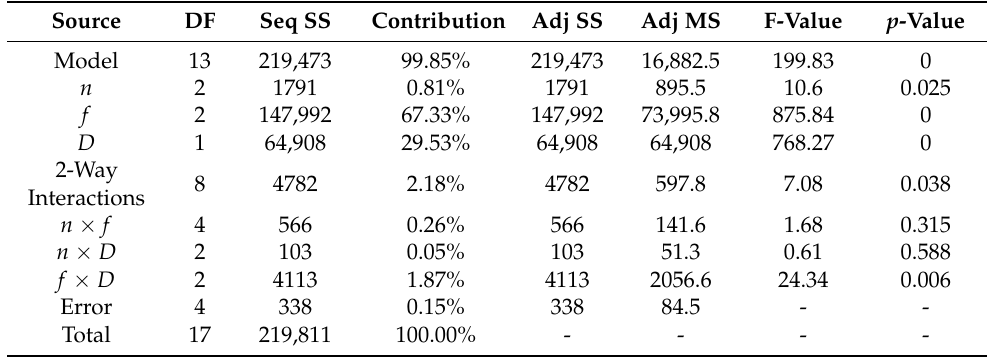
Figure 2. Average thrust force. Table 3. ANOVA for thrust force.